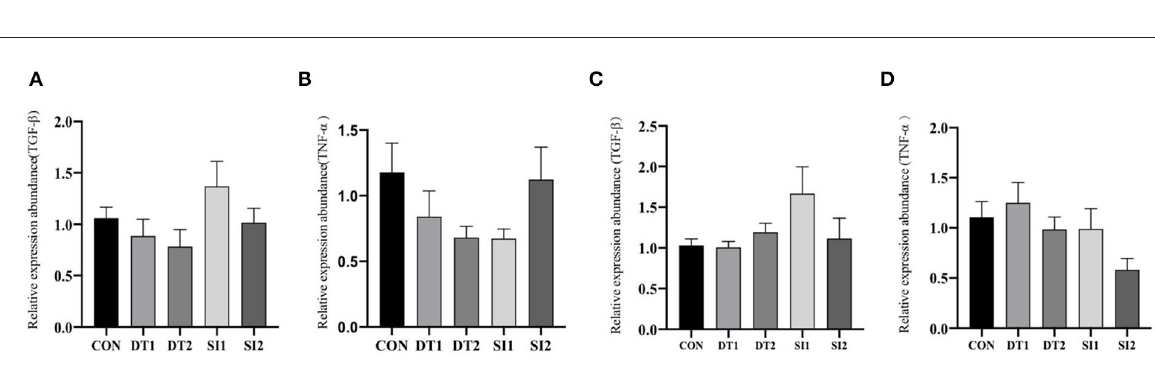
Staphylococcaceae , Burkholderiaceae , and Akkermansiaceae (Figure